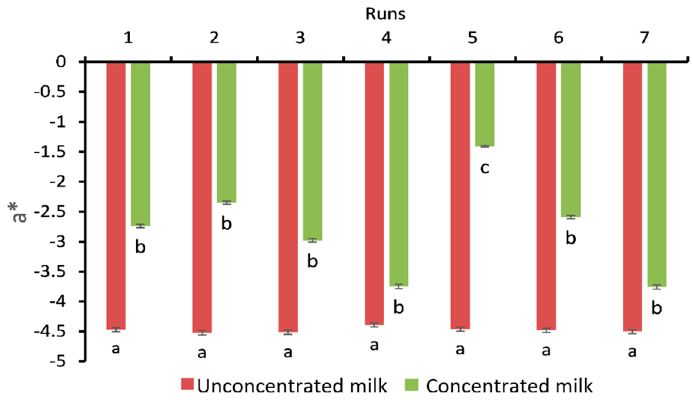
Figure 4. a* value of unconcentrated and concentrated milk. Different letters refer to significant differences between means.